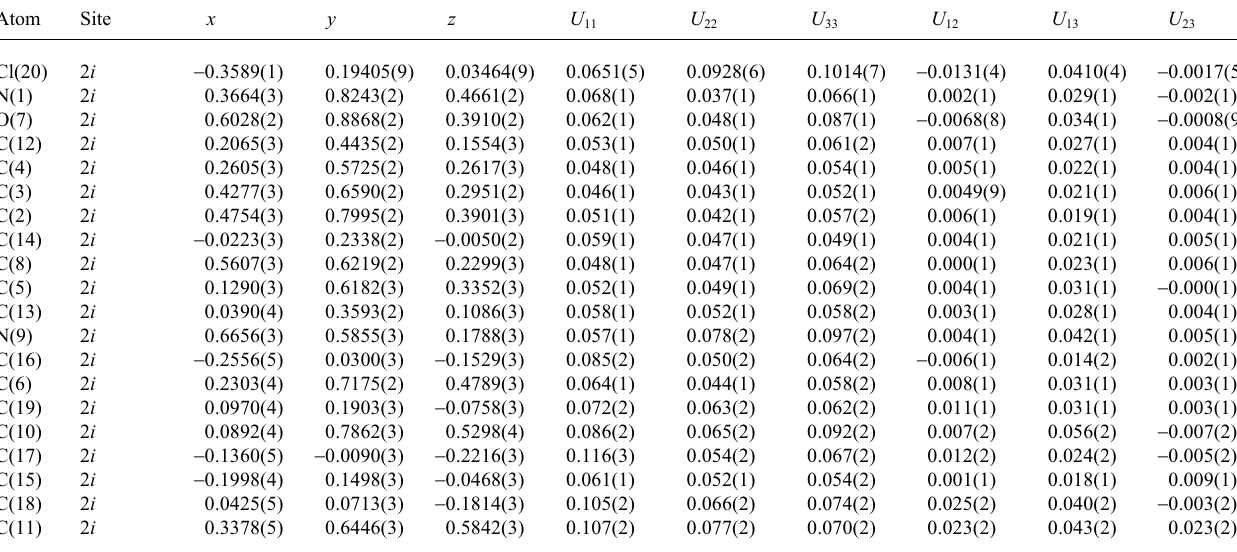
Table 3. Atomic coordinates and displacement parameters (in Å 2